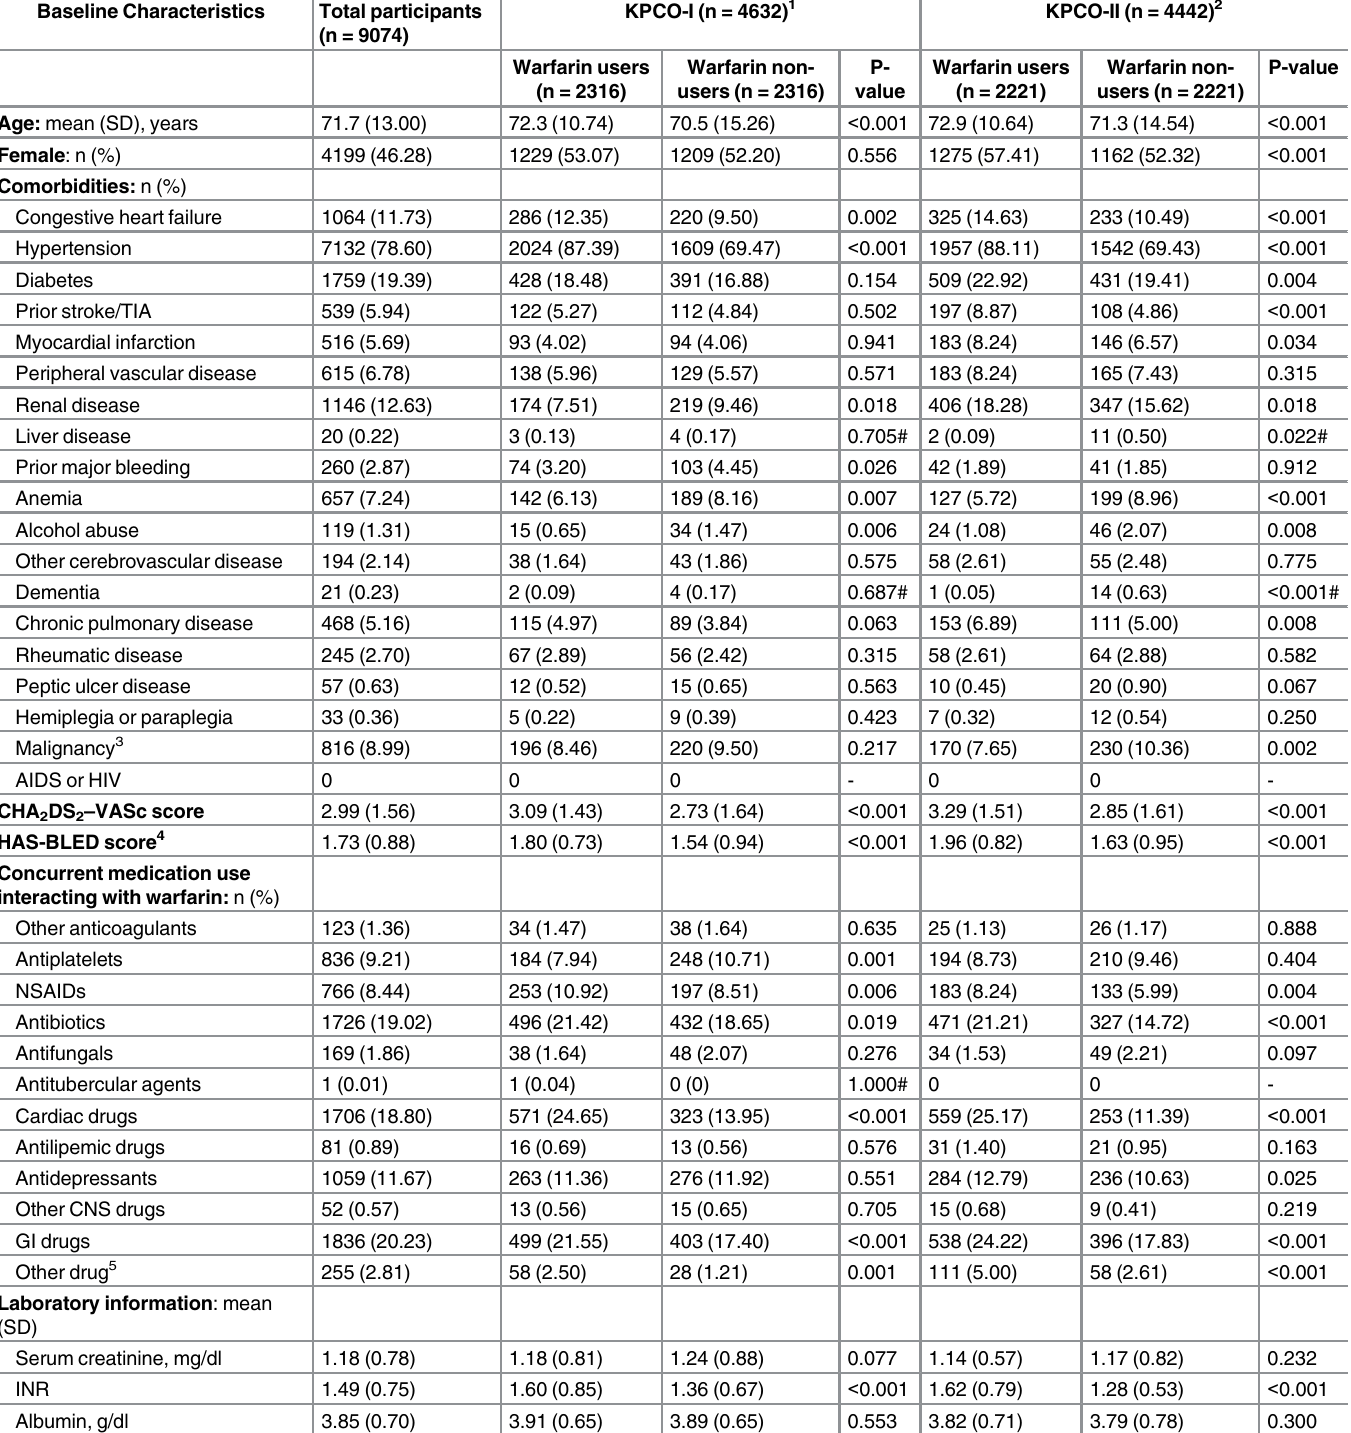
Table 2. Characteristics of study patients stratified by warfarin users versus non-users in derivation and validation